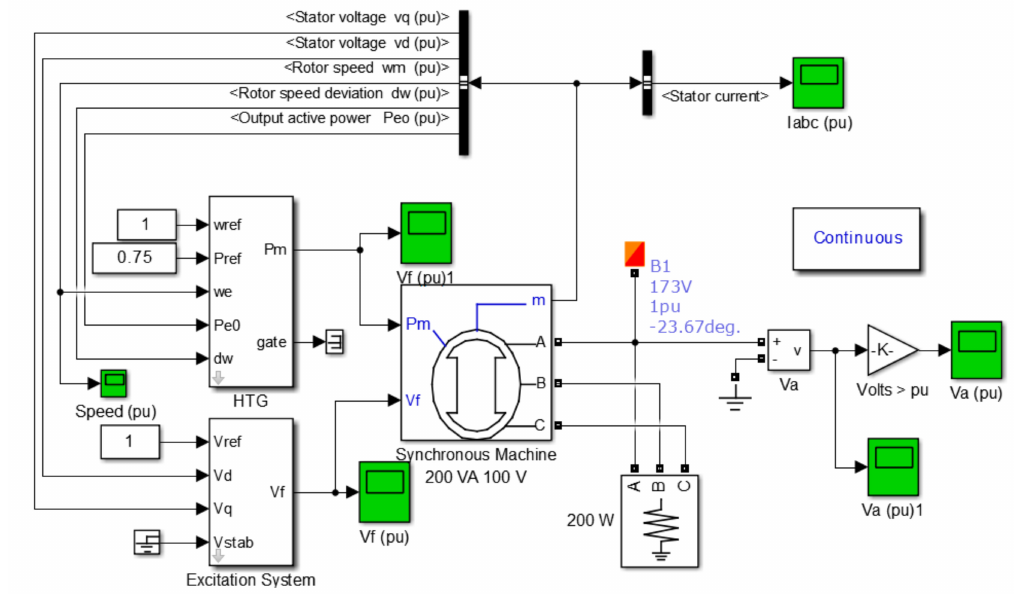
Figure 5. MATLAB / Simulink model of experimental